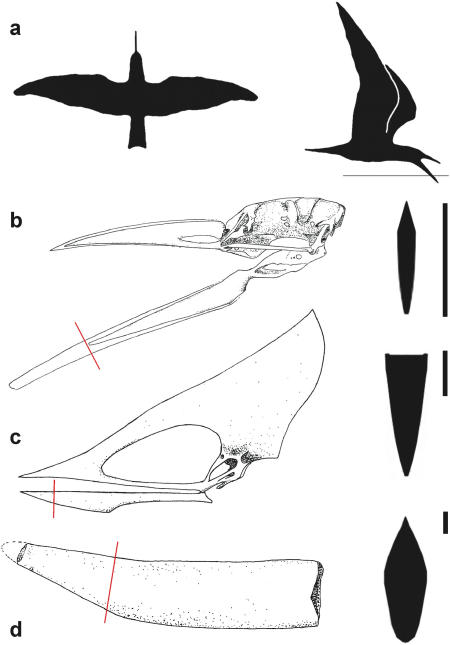
Comparative Dimensions of Rynchops and Pterosaur Lower Jaws(A) Dorsal (left) and lateral (right) views of Rynchops niger cinerascens in foraging flight. Flight altitude was estimated from bill length, bill penetration and bill angle (45 °).(B) Skull of Rynchops showing cross-sectional shape of lower jaw.(C) Skull of Tupuxuara sp. (IMCF 1052) and cross-section of lower jaw.(D) Jaw fragment of Thalassodromeus sethi (DGM 1476-M) and cross-section of lower jaw.Lines of sections indicated by red lines. Jaw section scale bars equal to 10 mm.